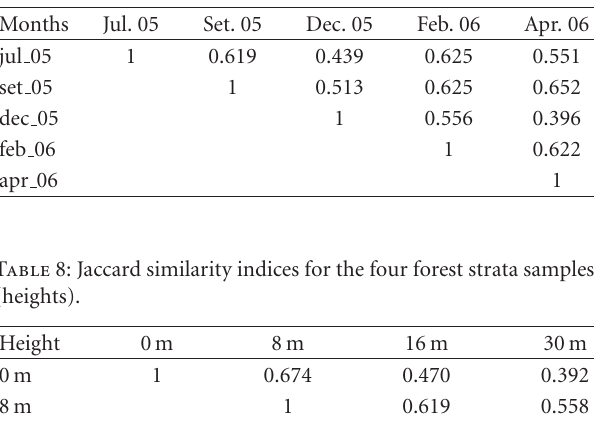
Table 7: Jaccard similarity indices for the five di ff erent temporal samples.